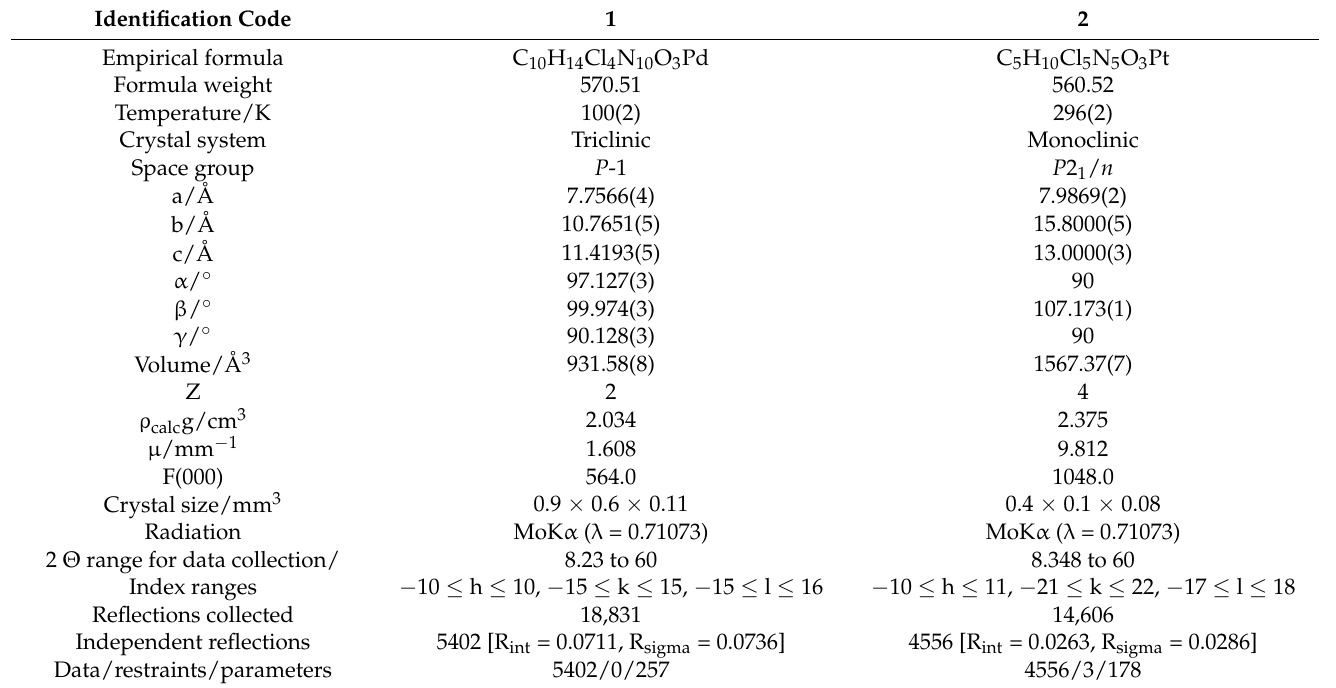
Table 1. Crystal data and structure refinement for structure 1 and 2